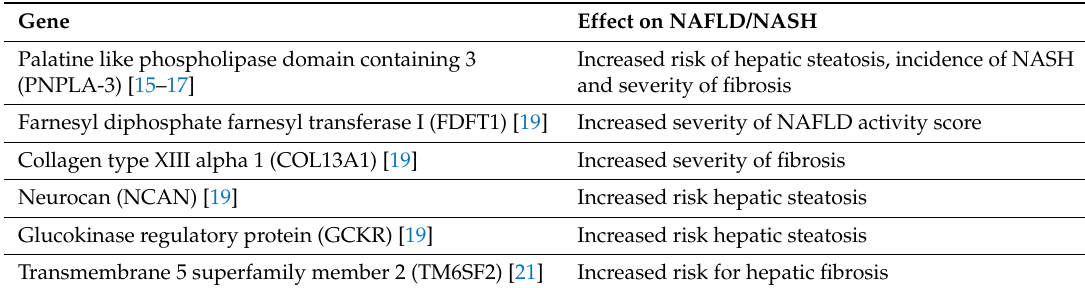
Table 1. Genetic variants associated with